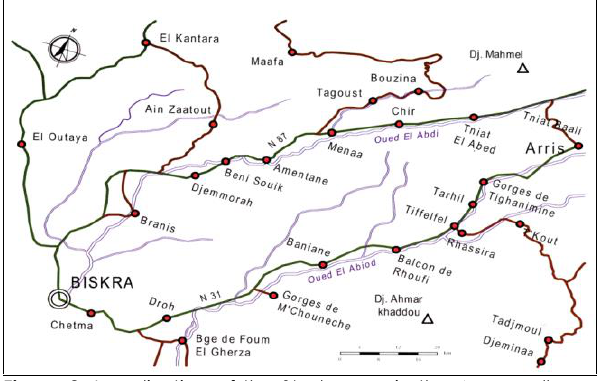
Figure 2. Localization of the Study area in the Aures valley. (N. Meghraoui Chouguiat.